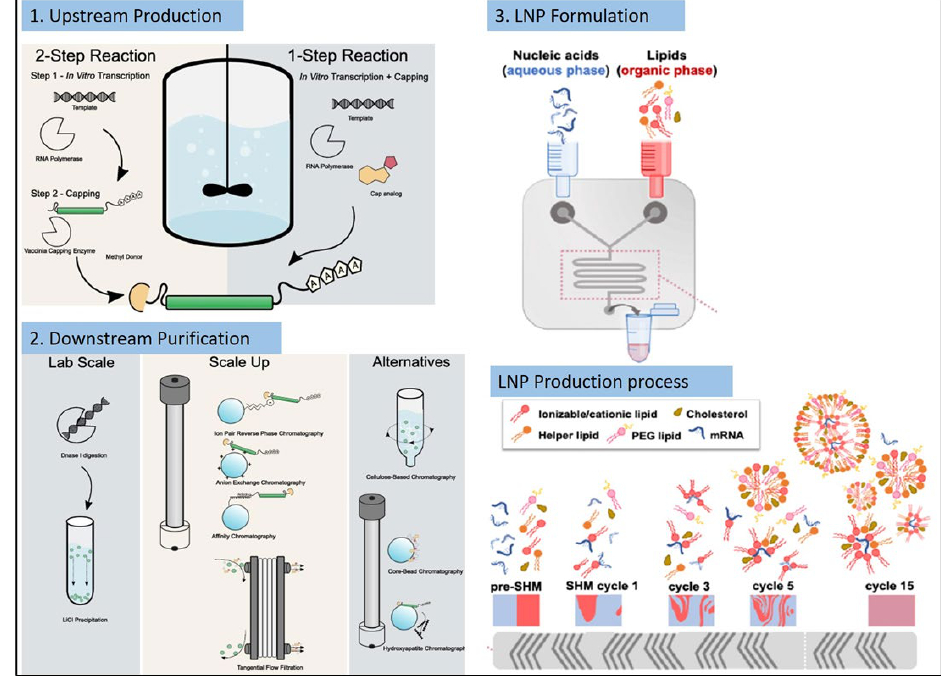
Figure 5. The steps and stages of an mRNA vaccine manufacturing process. mRNA vaccine pro- duction can be divided into three phases: upstream mRNA manufacturing, downstream mRNA purification, and formulation of mRNA lipid nanoparticles. mRNA production can be performed in a one-step co-transcriptional reaction, where a capping reagent is used, or in a two-step reaction, where the enzymatic capping is performed. mRNA purification process at a smaller lab scale consists of DNase I digestion enzyme followed by LiCl precipitation of the mRNA. Purification of mRNA at a large scale involves utilizing well-established chromatographic methods coupled with tangential flow filtration (TFF). Finally, the formulation of mRNA vaccines consists of mixing mRNA aqueous solu- tion with lipid solution in a non-aqueous phase. This causes self-assembly of the lipid nanoparticles (LNPs) and encapsulates the negatively charged mRNA within the core of the LNPs. The mixing of the mRNA and the lipid molecules in a staggered herringbone micromixer (SHM) occurs in various cycles which results in the formation of the final mRNA-LNP vaccines. Adapted with permission from